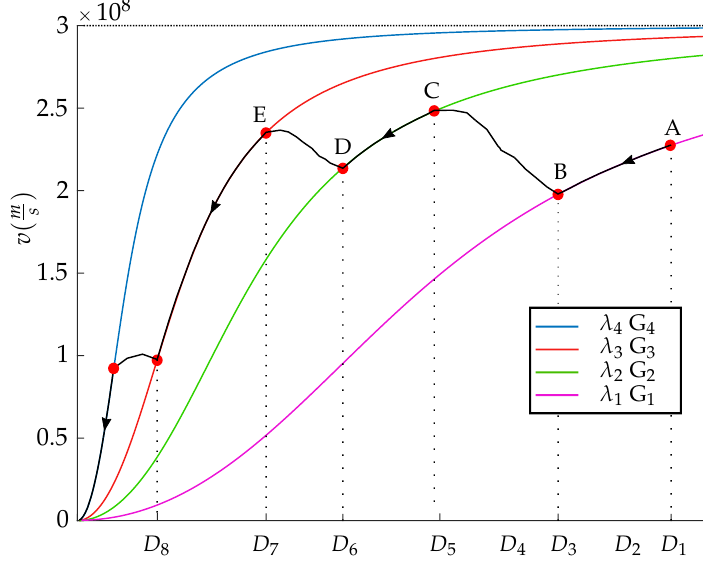
Figure 7. Stepped Leader speed